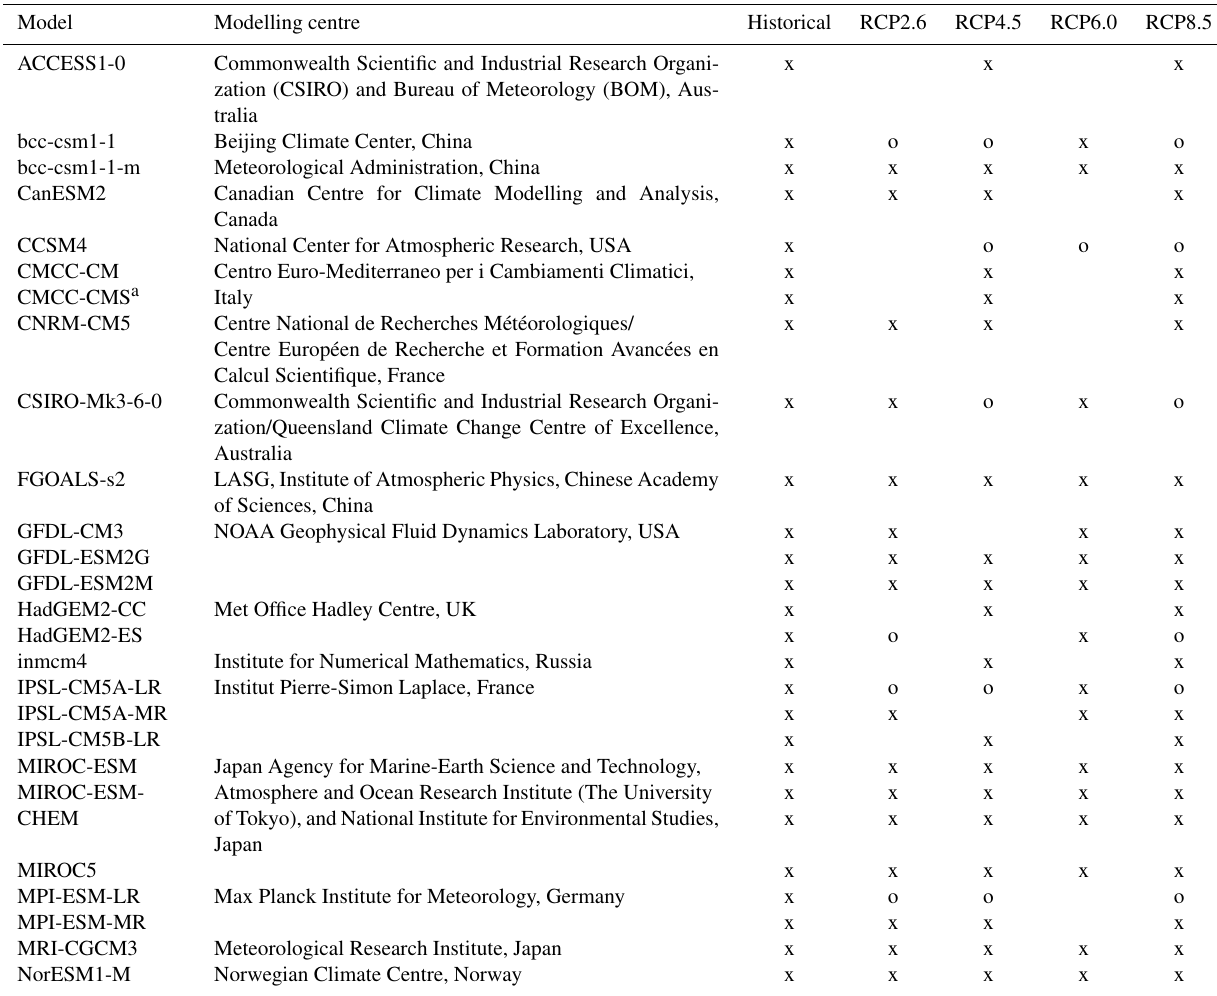
Table 1. List of models used in this study (in alphabetical order). Crosses (circles) indicate availability of simulations of the ensemble member r1i1p1 for the 1861–2099 (1861–2299) period. Note that the number of simulations of other ensemble members is considerably